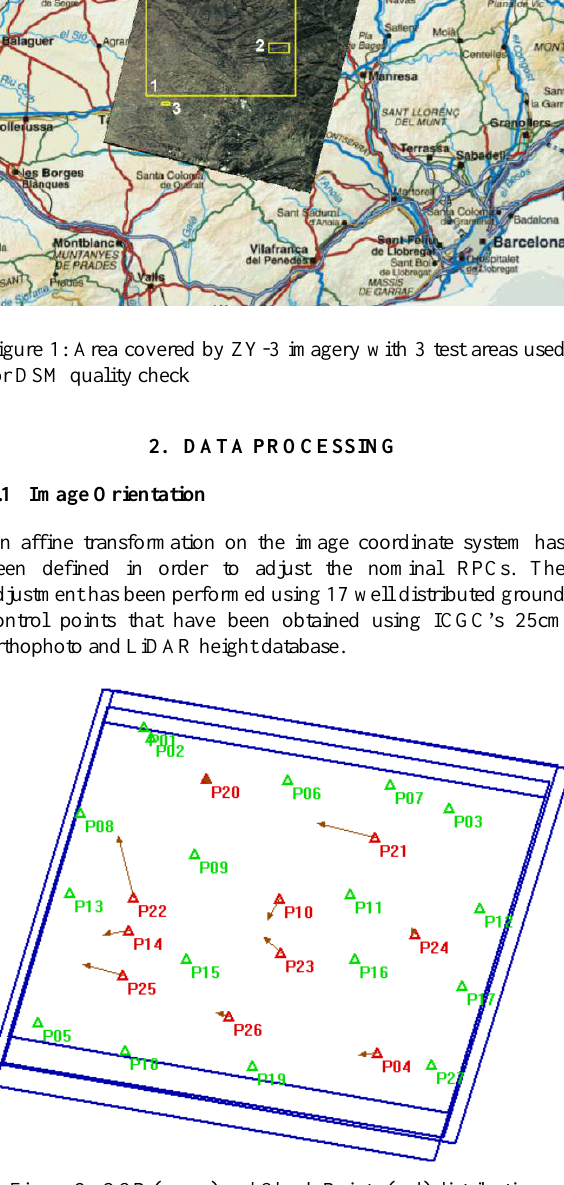
Figure 2 . GCP (green) and Check Points (red) distribution The final accuracy has been calculated using 10 additional ground check points.